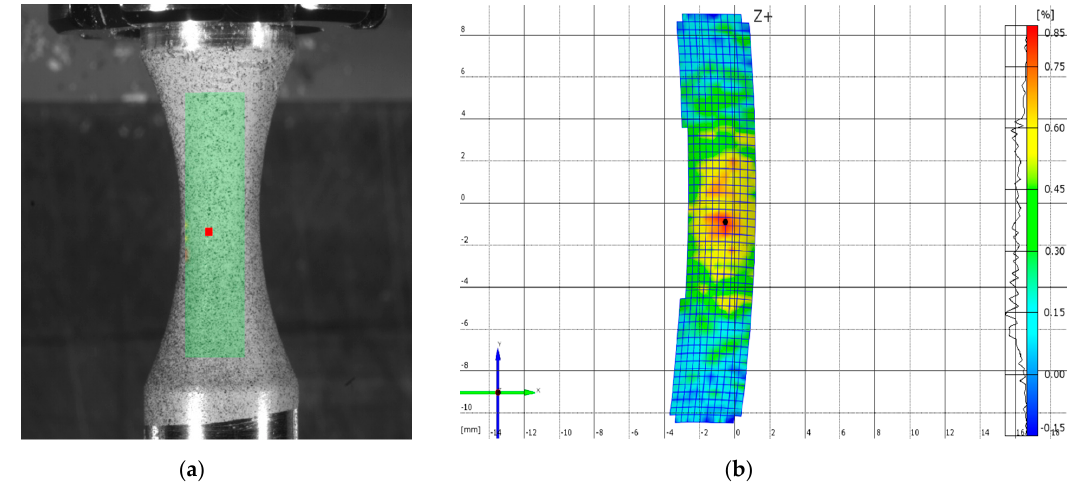
Figure 20. Assessing the images by the ARAMIS system: ( a ) the area of the assumed maximal deformation; ( b ) the deformation zones of the specimen.